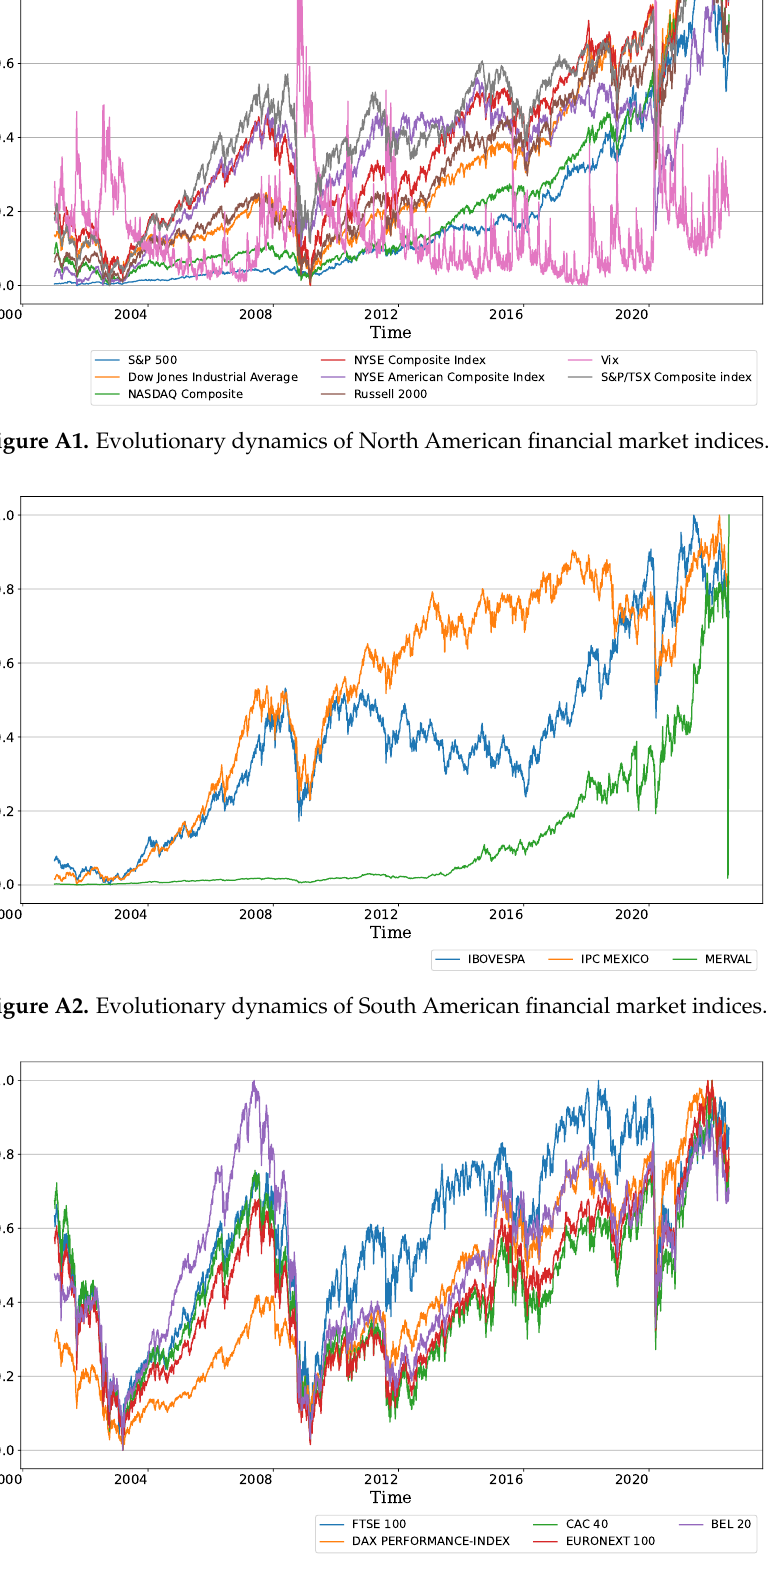
Figure A3. Evolutionary dynamics of European financial market